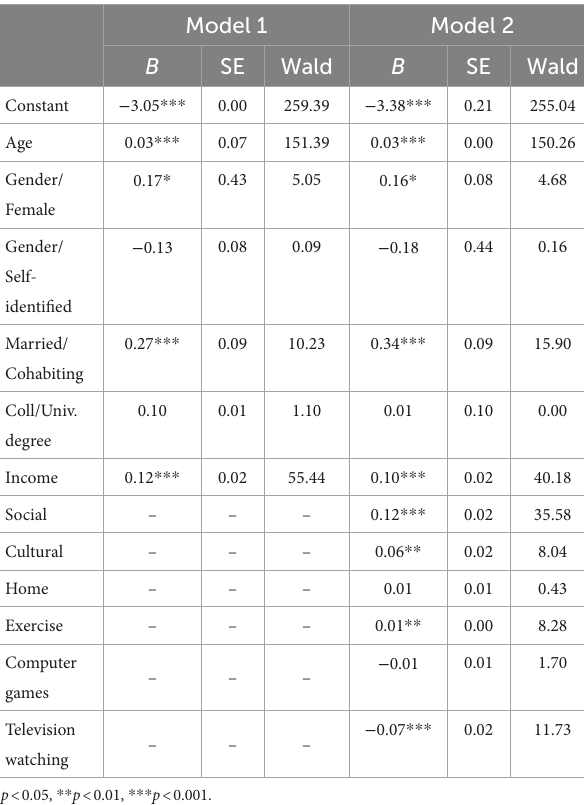
TABLE 3 Binary logistic regression models showing the association of demographic characteristics and leisure activity participation with languishing (vs. moderate health and flourishing).